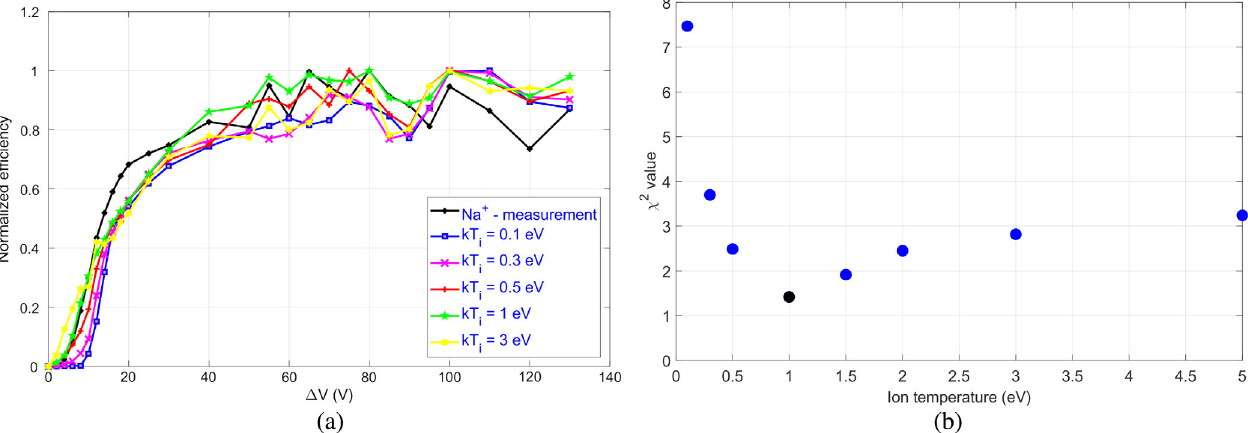
FIG. 8. (a) Comparison of simulated and experimental Na 1 þ Δ V curves acquired from k T sweep. The minimum χ 2 value (optimum value of k T